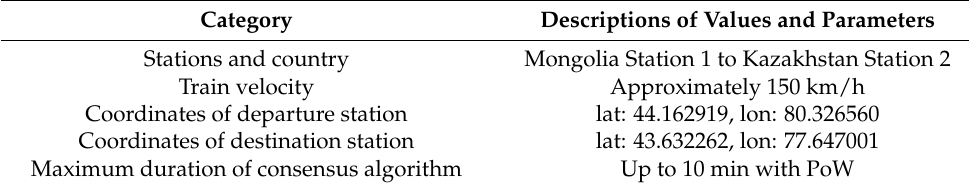
Table 4. Numerical values and parameters required for experiments.